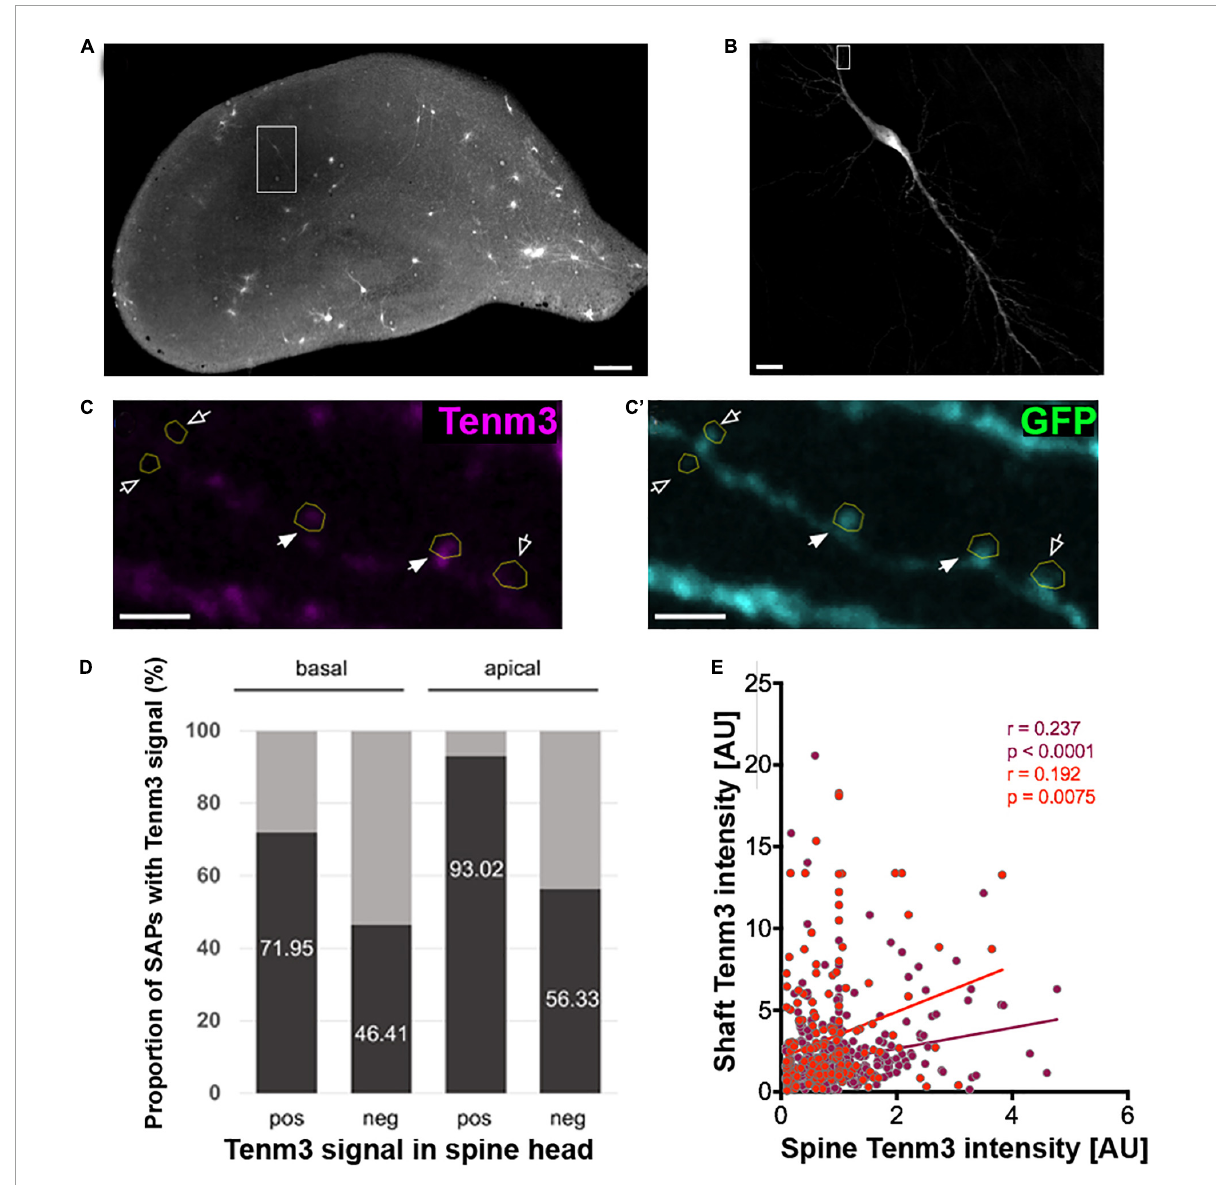
FIGURE3 Tenm3 is localised to SAPs in CA1 neurons. (A) Organotypic hippocampal slice biolistically transfected with Tenm3 and GFP. White square indicates a positively transfected CA1 neuron. (B) Magnified view of transfected CA1 neuron. (C,C’) Representative images showing the expression of Tenm3 and GFP in a basal dendritic segment of the CA1 neuron from panel (B) . Dendritic spines are indicated by yellow ROIs. Note the different Tenm3 levels in neighbouring spines, with some spines expressing Tenm3 (filled arrows) and some devoid of Tenm3 expression (empty arrows). (D) Proportion of SAPs with high and low Tenm3 signal below basal and apical Tenm3-positive and -negative spines. (E) Correlation of SAP- and spine-Tenm3 intensity in basal (purple) and apical (red) dendrites. r , non-parametric Spearman correlation coefficient. SAP: Spine Attachment Point. Scale bar, 200 µ m (A) , 20 µ m (B) , and 10 µ m (C)